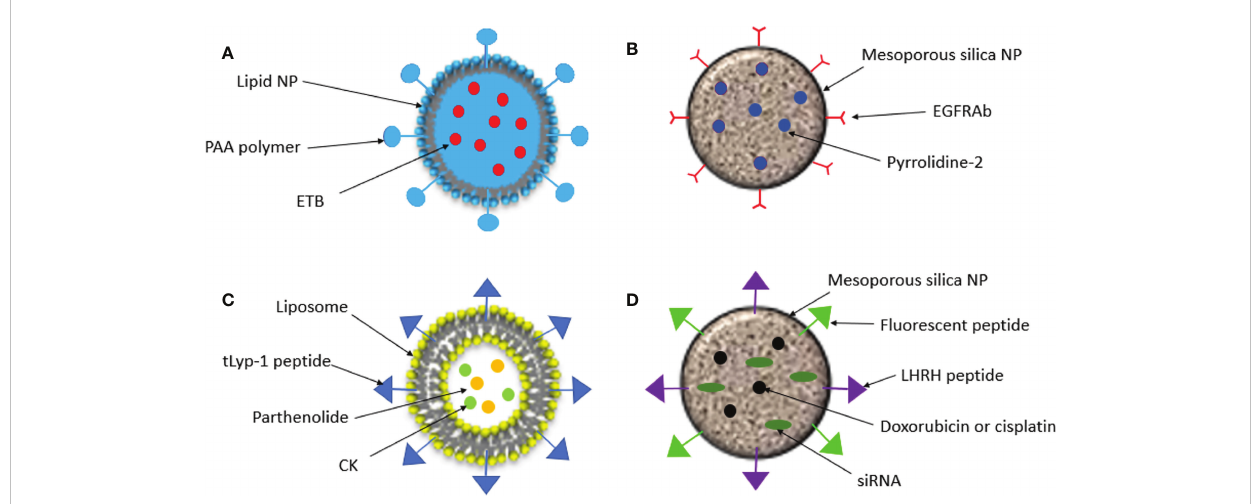
FIGURE 2 Schematic representation of nanoparticles created for targeted drug delivery in NSCLC. (A) . Lipid NPs were conjugated with the pH sensitive polymer, poly (acrylic acid) (PAA) and loaded with the kinase inhibitor Erlotinib (ETB). (B) . EGFR antibodies (EGFRAbs) were conjufated to silica NPs which were loaded with pyrrolidine-2, an inhibitor of cytosolic phospholipase A 2 a , cPLA2 a . (C) . Liposomal NPs were coated in tLYP-1 peptide and loaded with parthenolide and compound K (CK). (D) . Silica NPs were loaded with doxorubicin or cisplatin and an siRNA and an LHRH peptide was conjugated to target the tumor and a fl uorescent protein was conjugated to measure fl uorescence